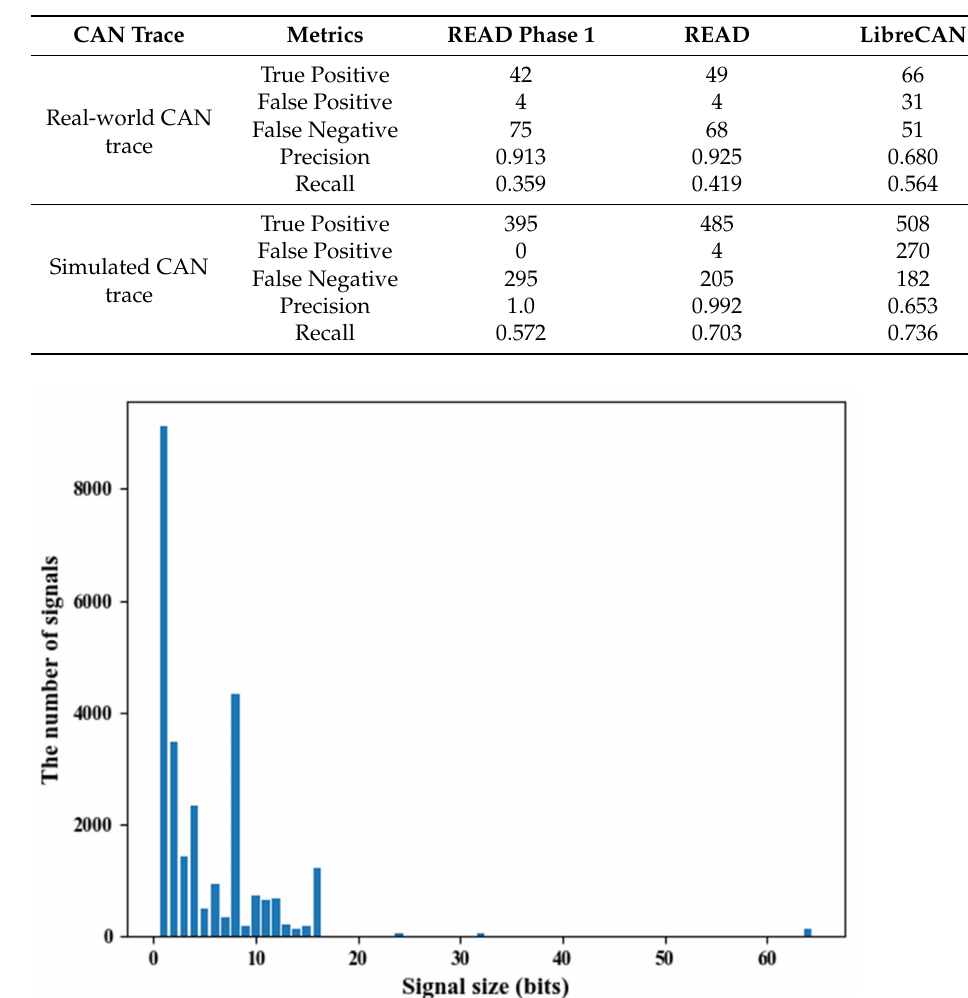
Table 1. TP, FP, FN, precision, and recall of the three CAN reverse-engineering algorithms on a real car’s CAN trace and a synthetic CAN trace (both 1M messages).